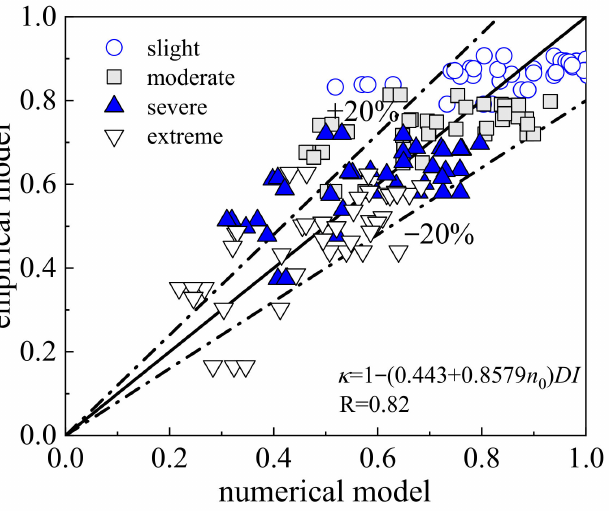
Figure 12. Comparison between predicted value of empirical model and value of numerical